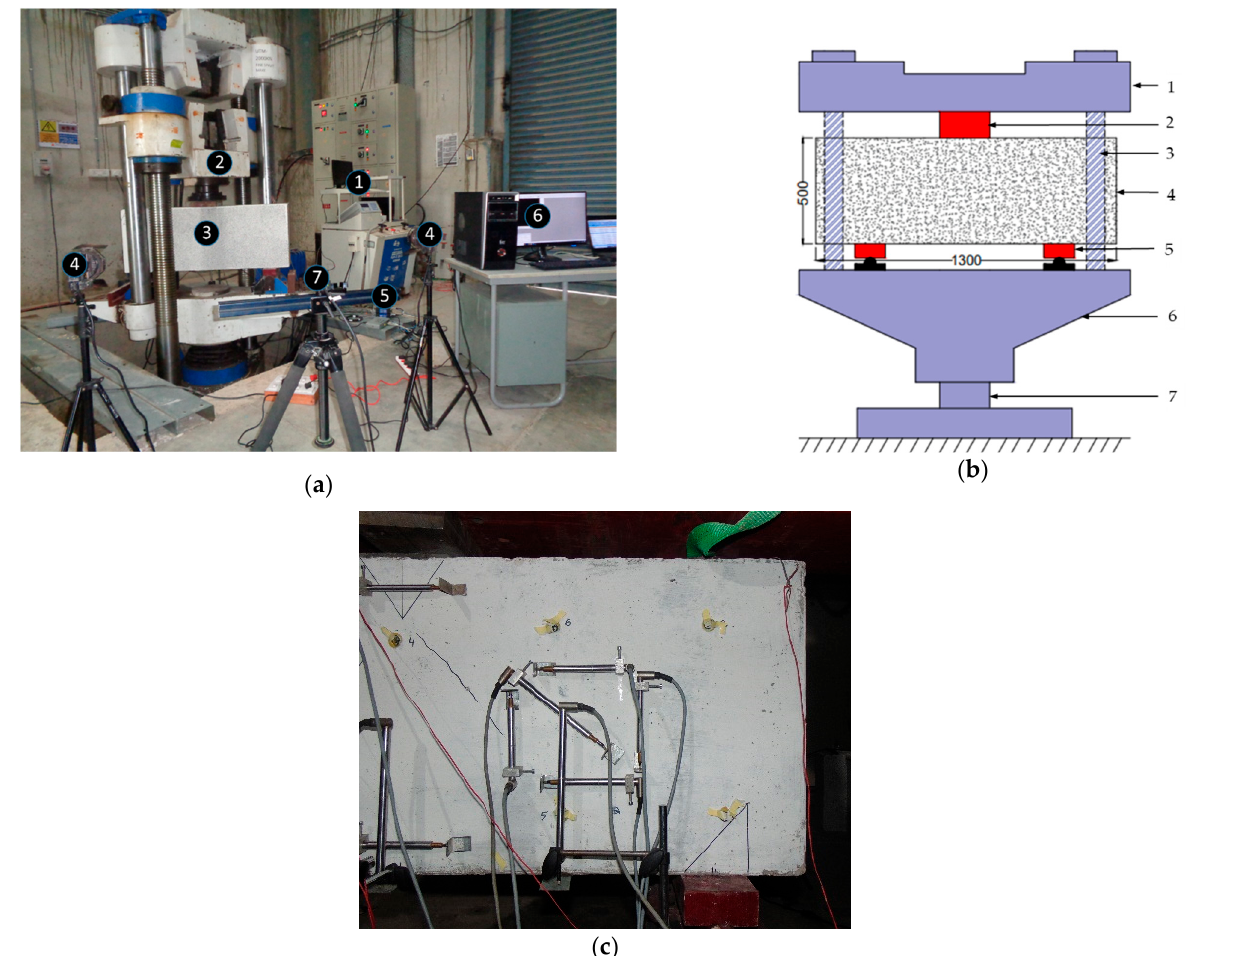
Figure 6. ( a ) Test setup and instrumentation of deep beams, (1. controller, 2. UTM of 2000 kN capacity, 3. test specimen, 4. light source, 5. data acquisition system (DAQ), 6. data storage (DIC+DAQ), 7. DIC camera). ( b ) Schematic diagram of the test set-up, (1. fixed head, 2. loading plate, 3. connecting posts, 4. test specimens, 5. support plate, 6. movable head, 7. hydraulic cylinder). ( c ) Instrumentation on the rear face of deep beam.